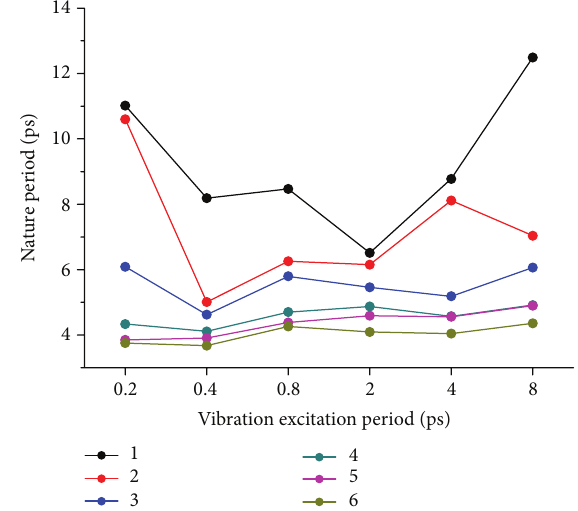
Figure 9: The relationship between the vibration periods and the first six order nature periods of the VEMD final